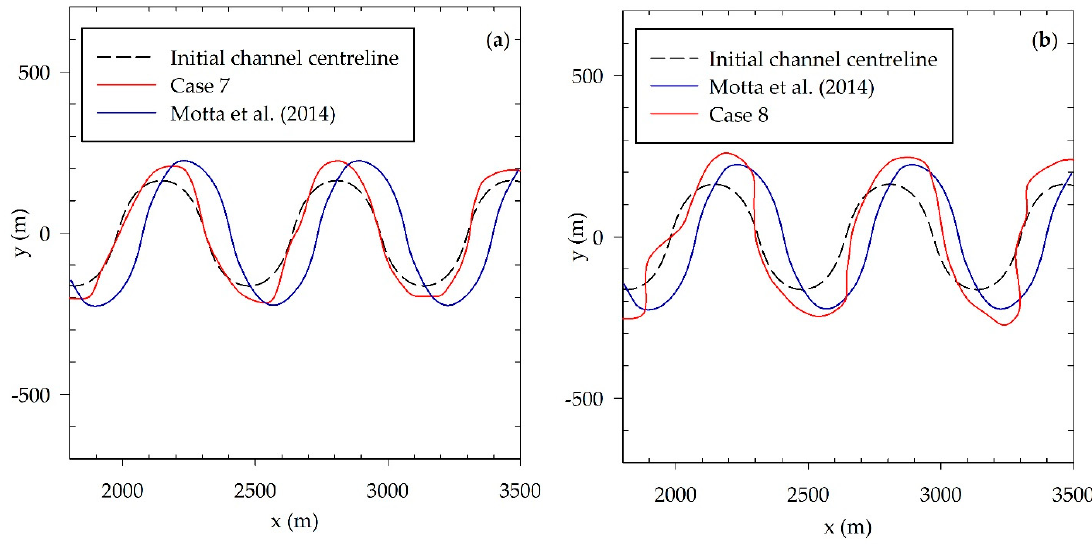
Figure 11. Comparison of Cases 7 and 8 with the simulations of Motta et al. [18]: ( a ) Case 7 and ( b ) Case 8.